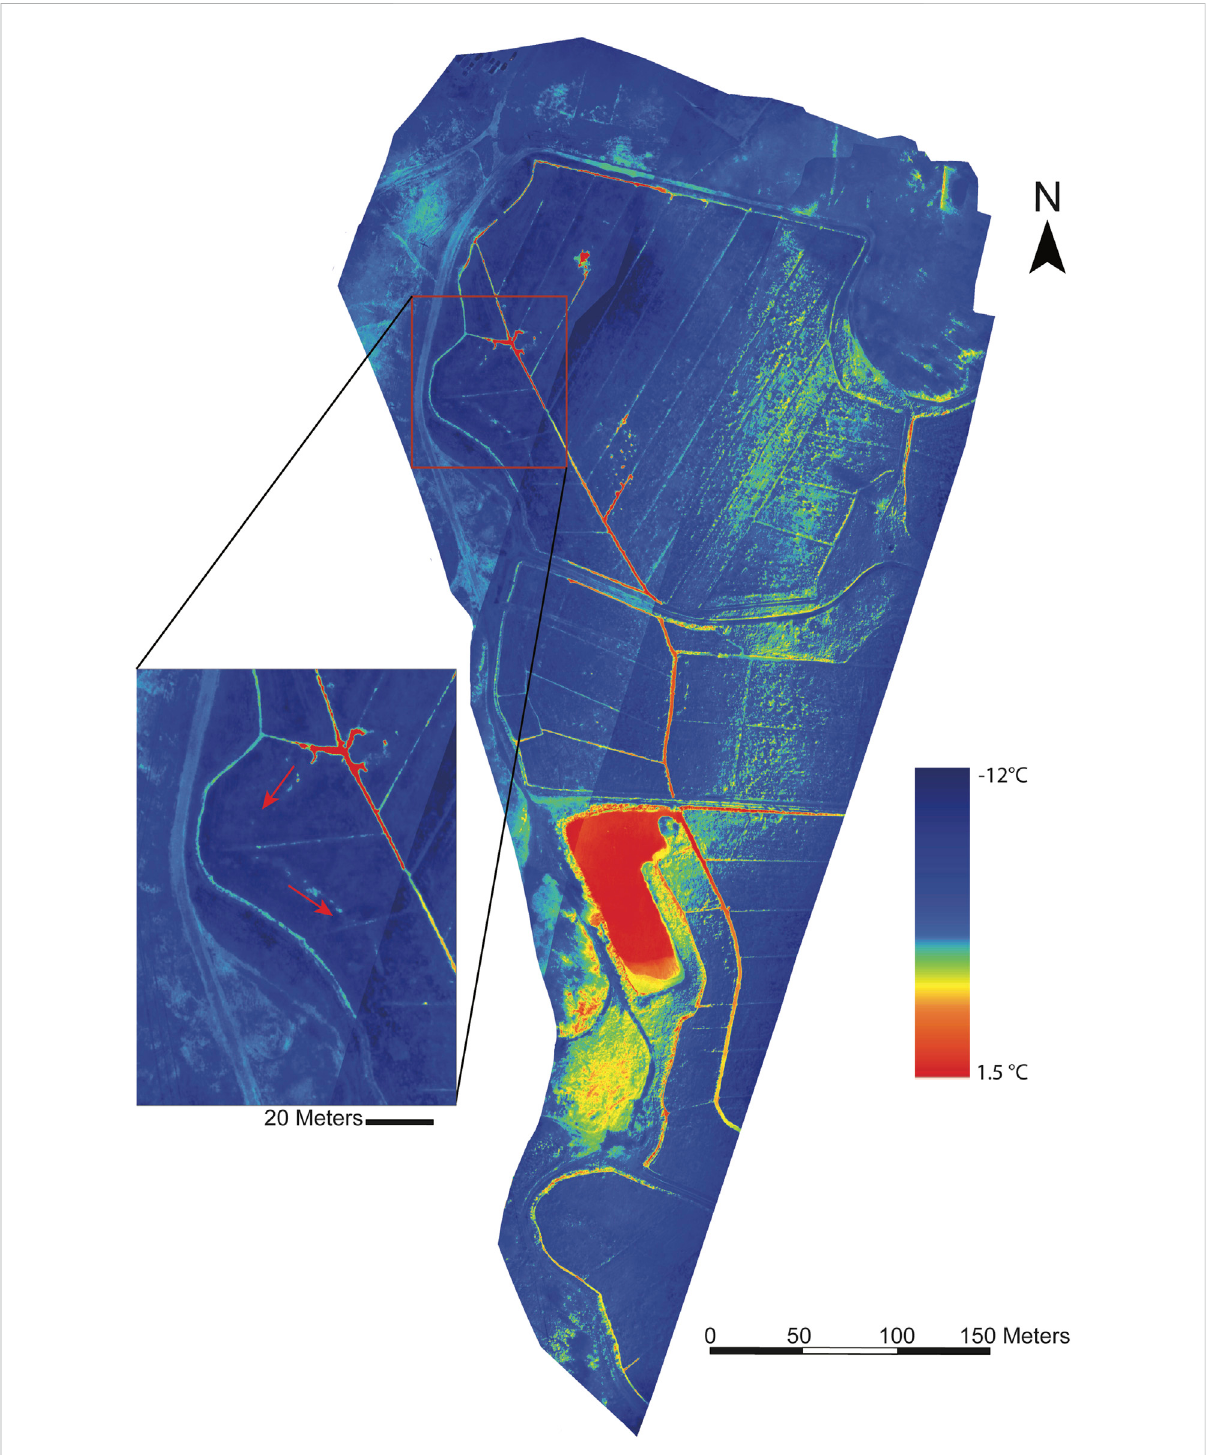
FIGURE 3 Orthomosaic image of pre-restoration UAS-derived thermal infrared imagery 8 February 2020. Ground surface is cold (blue), and discrete warmer groundwater springs show up as warm (red) dots and fl ow into surface ditches. The inset image shows the hypothesized location of the original stream channel, with red arrows indicating fl ow